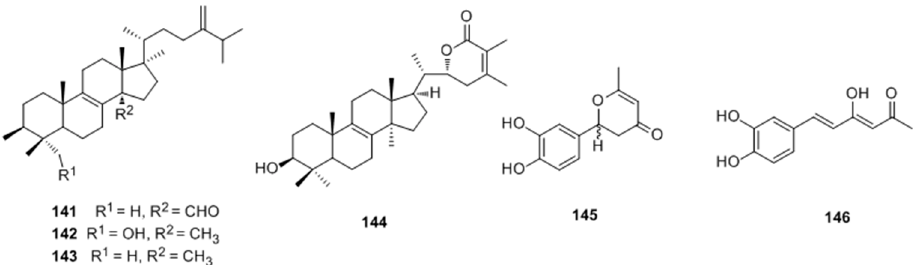
Figure 27. Structure of triterpenoids and phenolic compound isolated from fruiting bodies of Inonotus hispidus .